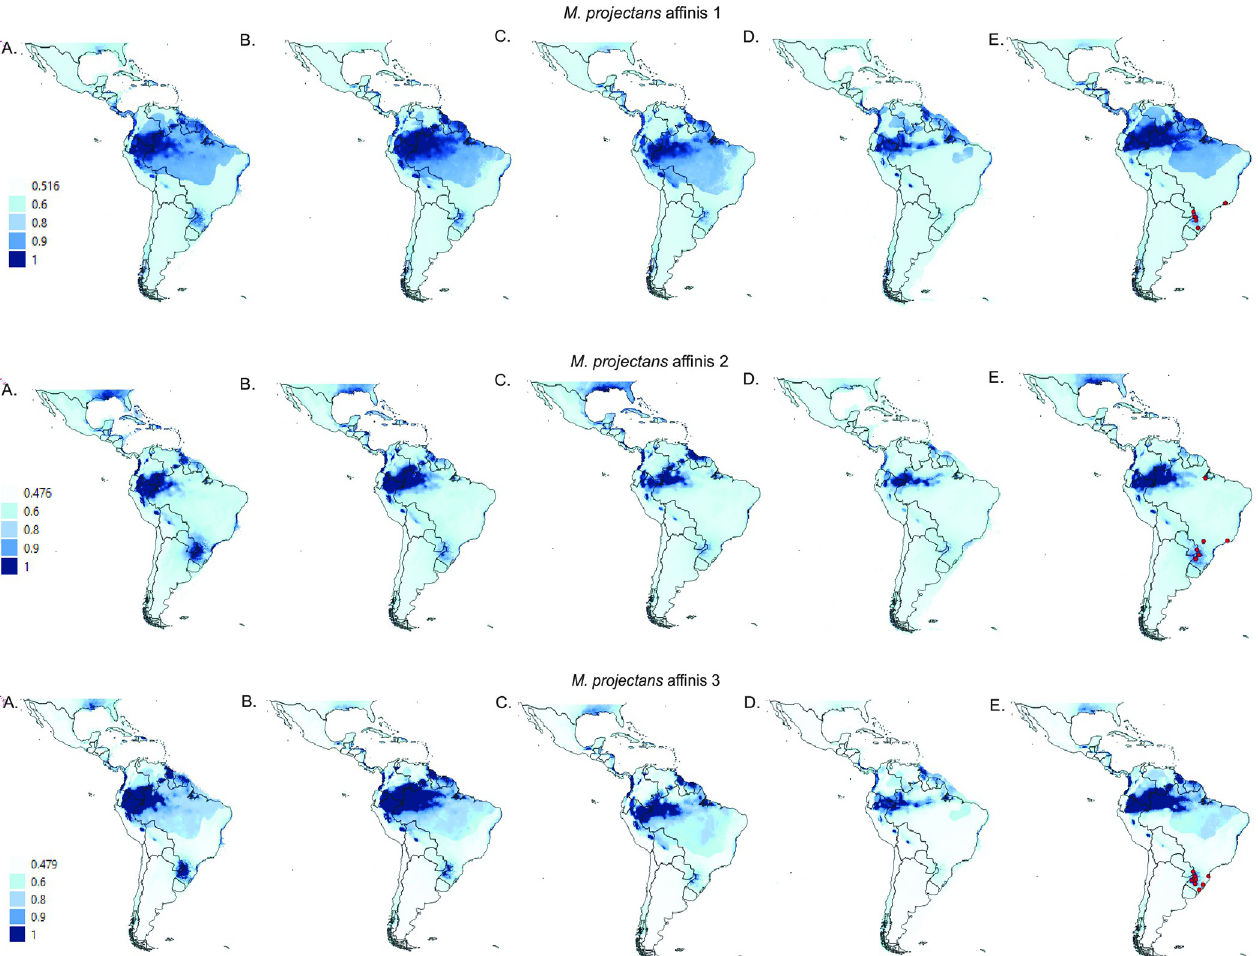
Fig 5. Environmental distribution models predicted by maximum entropy for each of the three species of the M . projectans complex for the (A) Pliocene, (B) Pleistocene (787 kya), (C) Last Interglacial, (D) Last Glacial Maximum, (E) Present. Neotropical shapefile was obtained from Lo¨wenberg-Neto [108], as available at